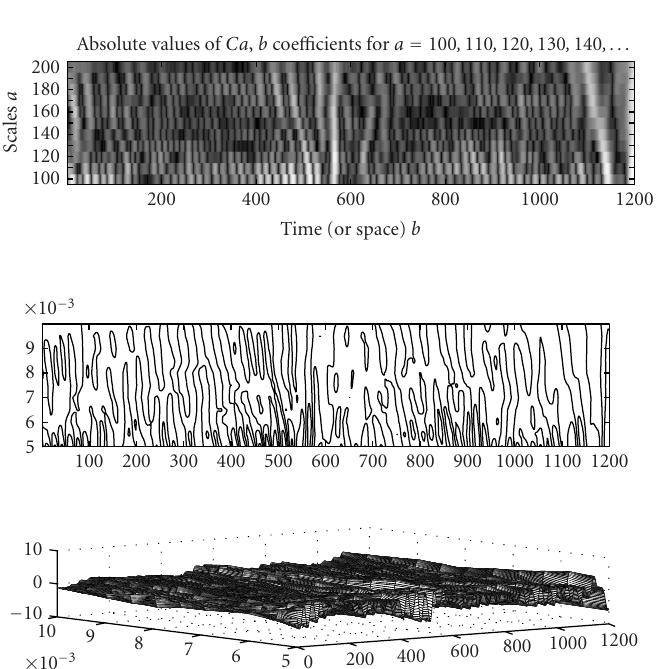
Figure 3.5. Continuous wavelet transform with